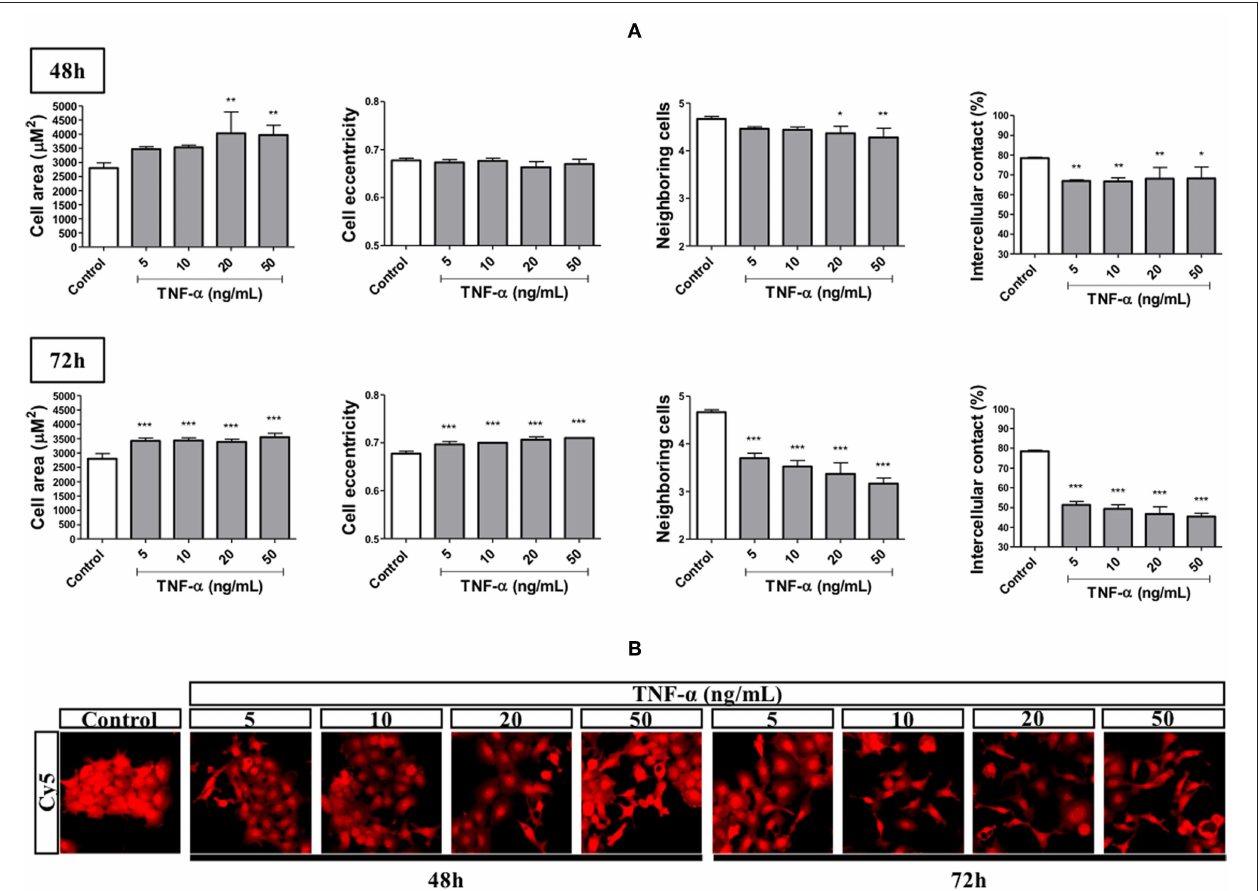
FIGURE 2 | Effects of TNF- α in EMT-related morphometric parameters. The FADU cell line was stimulated or not (Control) with TNF- α (5 to 50ng/mL), for 48 or 72h (squares). At the endpoint, the cells were stained with nuclear (Hoechst) and cytoplasmic (CellMask) fluorescent dyes. Images (nine fields per well) were acquired using a 10X objective and excitation/emission filters DAPI (Hoechst) and Cy5 (CellMask), using an ImageXpress Micro XLS HCS system (Molecular Devices). Images were analyzed using CellProfiler, in order to quantify the following parameters: cell area, cell eccentricity, number of neighboring cells and percentage of intercellular contact. (A) Quantitative changes (Mean + -SD) in morphometric parameters due to TNF- α stimulation for 48 and 72h. (B) Representative images of cells stimulated with TNF- α for 48 and 72h. Statistically significant differences (ONE-WAY Anova with Tukey post-test), in comparison to the control condition: * p < 0.05; ** p < 0.01; *** p <